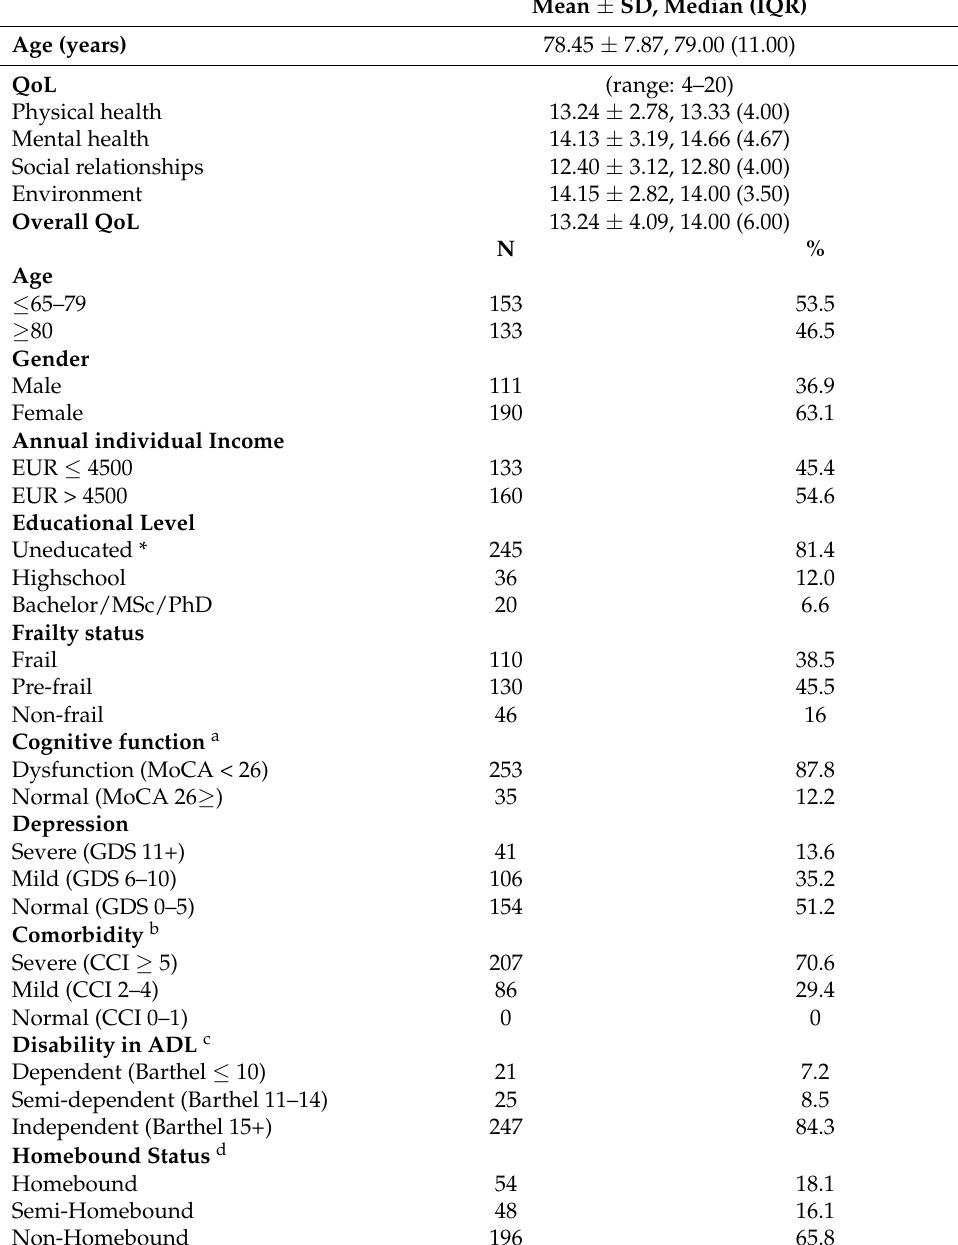
Table 1. Descriptive characteristics of the participants (n =